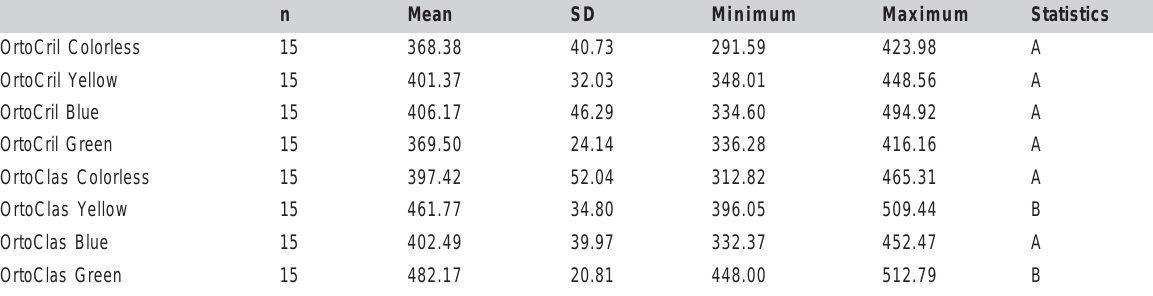
Different letters mean statistically significant difference (p <